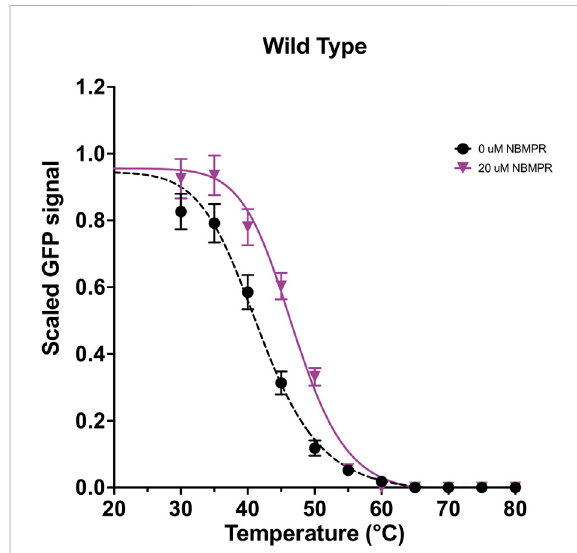
FIGURE 1 Stability curves for wild type hENT1 in both apo and NBMPR- bound states. Wild type apo -state and NBMPR curves were collected as an average of at least three repeats. Error bars are representative of SEM. Data were fi t with a four-parameter dose-response curve (variable slope) by non-linear least-squares fi tting in GraphPad Prism